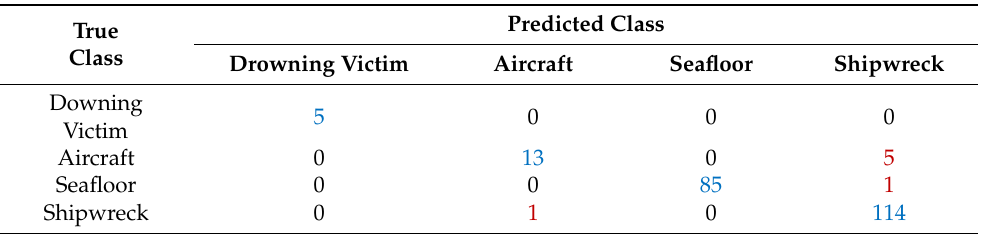
Table 4. Confusion matrix derived from fine-tuning the pre-trained vgg19 network using real side-scan sonar images and “simulated side-scan sonar images”.